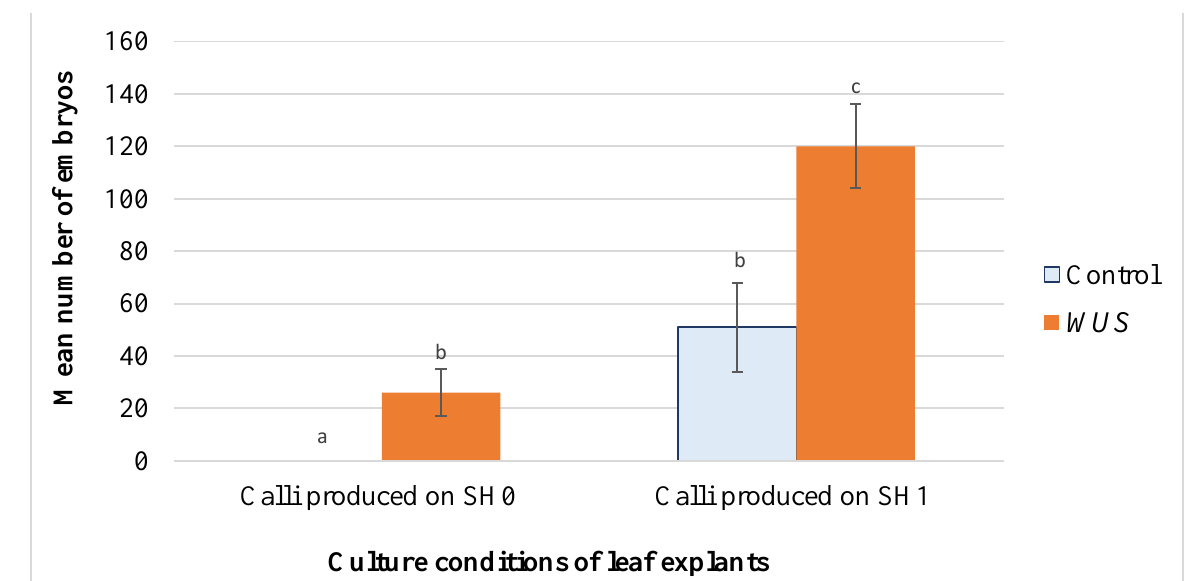
Figure 5. Embryo production from leaf explants of Medicago truncatula . Mean number of embryos produced on calli formed leaf explants of M. truncatula transformed using pCambia- BAR (Control) and pCambia1301- WUS-BAR l ( WUS ) cultured on SH2 (without growth regulators). These calli were produced on SH0 (without growth regulators) or on SH1 (4 mg.L − 1 2,4-D, 0.5 mg.L − 1 BAP). Data represent the mean ± standard errors of three replicates. Bars with different letters were significantly different at p < 0.05.